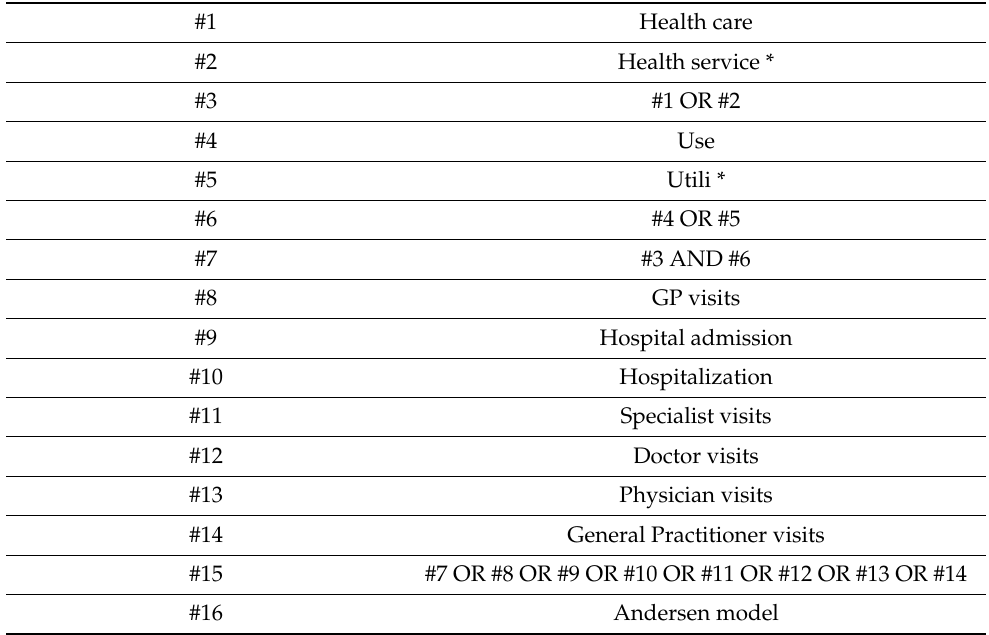
Table 1. Search strategy for